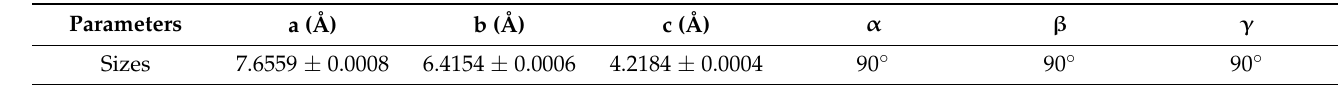
Table 3. IMC Lattice parameters [11].